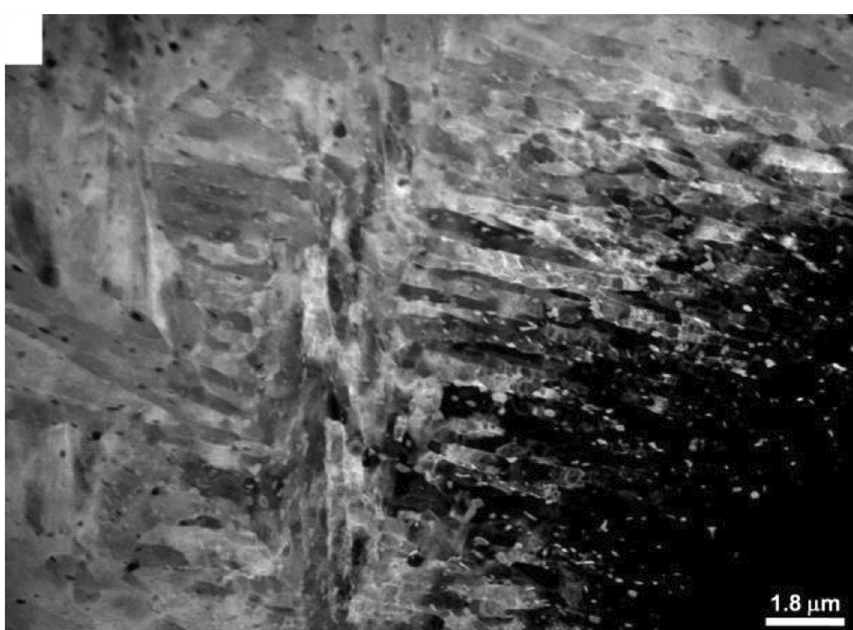
Figure 2. TEM micrograph showing the microstructure of RPV steel forgings in quenched and tempered